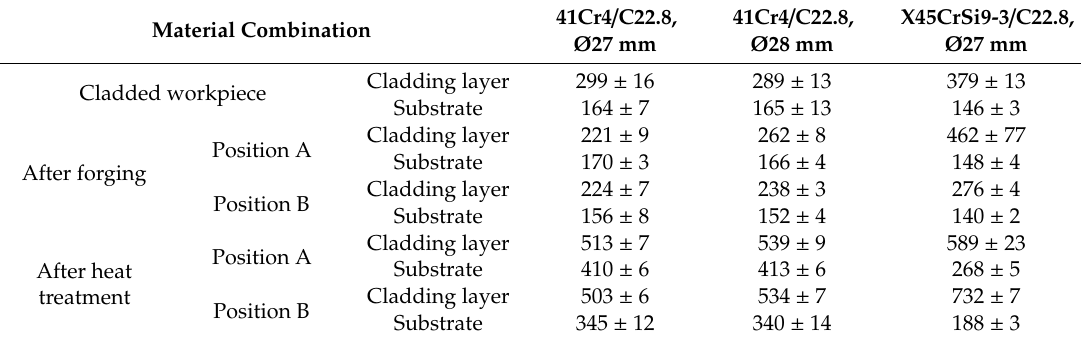
Figure 7. Sampling positions of the cross-sectional micrographs for metallographic examination and hardness measurements ( a ), extraction position of the sample plates ( b ), extraction position of the tensile specimens from the sample plates ( c ), geometry of the micro tensile specimen ( d ). Table 2. Average hardness values (HV 0.5) of cladding and substrate after cladding, forging and heat